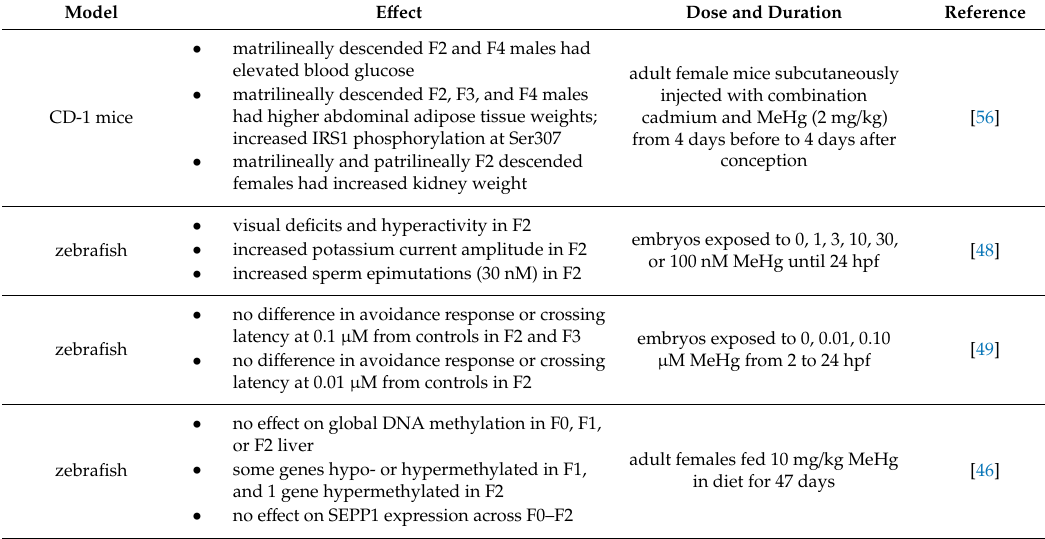
Table 3. Methylmercury e ff ects on transgenerational